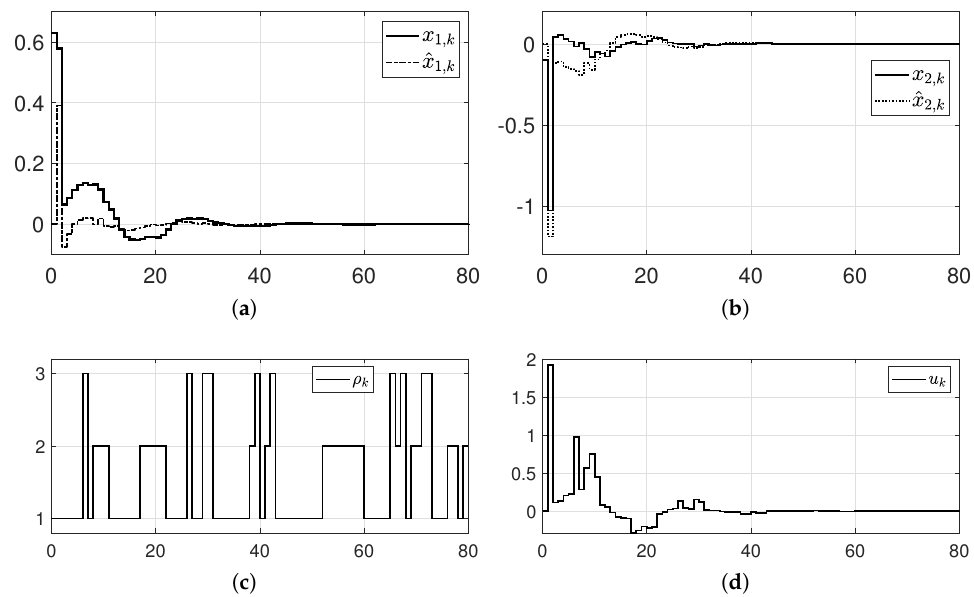
Figure 3. Simulation results of Example 3: ( a , b ) actual and observed states of (40), ( c ) system mode, and ( d ) control